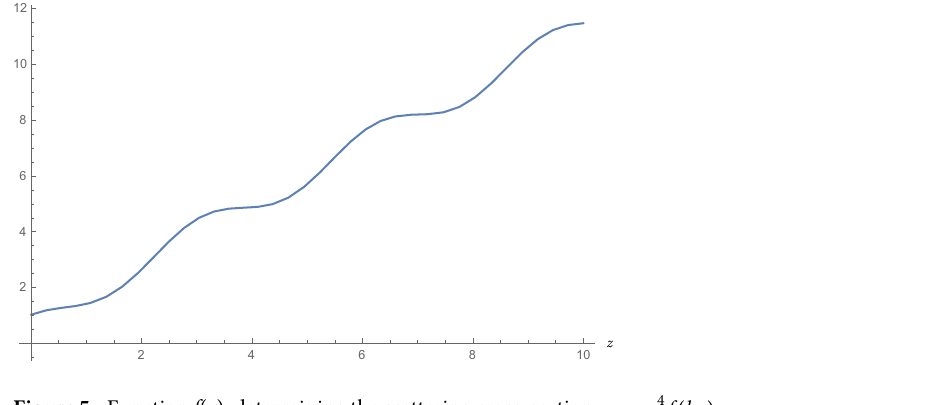
Figure 5. Function f ( z ), determining the scattering cross-section, σ = f ka ( )